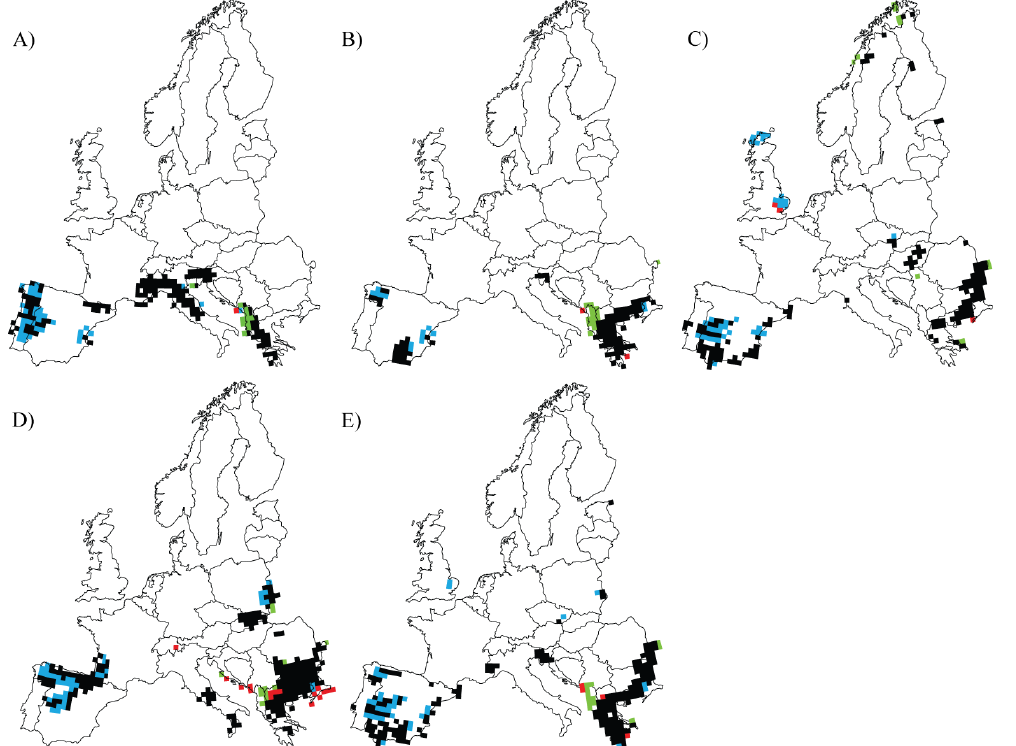
Figure 3. Distribution of cells representing high-value biodiversity areas for amphibians (A) , reptiles (B) , birds (C) , mammals (D) , and all taxa together (E) across continental Western Europe and Great Britain. Colors di ff erentiate between high-value biodiversity area cells that contain protected areas included in both the World Database on Protected Areas and the NATURA 2000 network (black) from those cells that represent full gaps with respect to either the World Database on Protected Areas (blue), the NATURA 2000 network (green), or both networks combined (red). Table 1. Summary of results on the amounts of (1) cells comprising HVBAs for the species of four vertebrate groups (based on combined biodiversity index values obtained for each group; see Methods) and for all species (based on standardized biodiversity index values); (2) species occurring in HVBA cells; and (3) HVBA cells not included in the WDPA, NATURA 2000 and combined protected area networks (i.e. gap